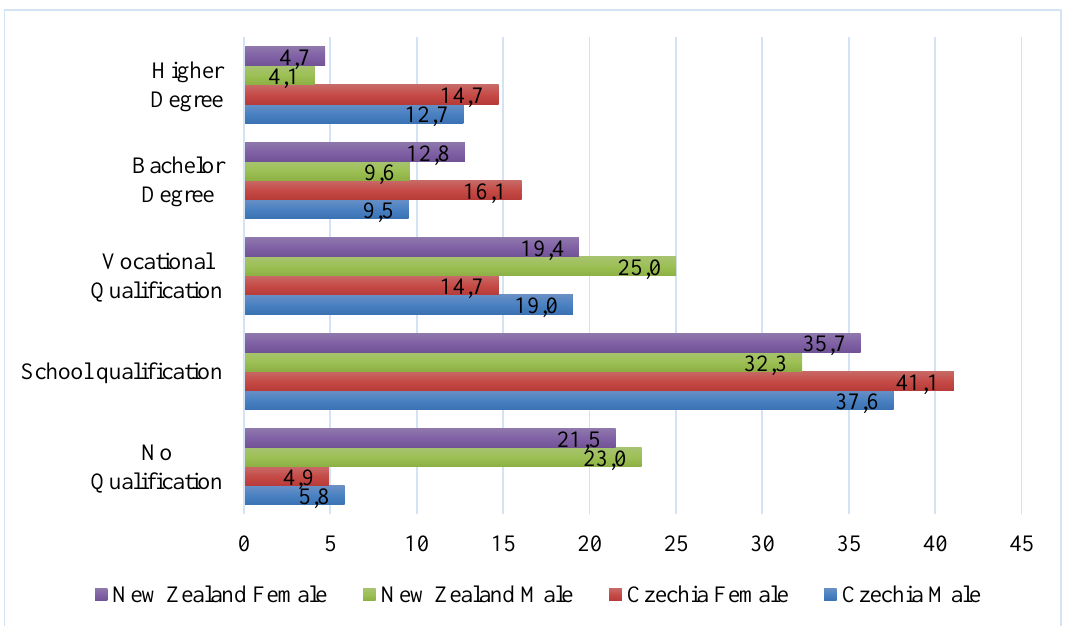
Figure 4. Highest educational qualification of the population aged 15+ years by birthplace (%), 2013